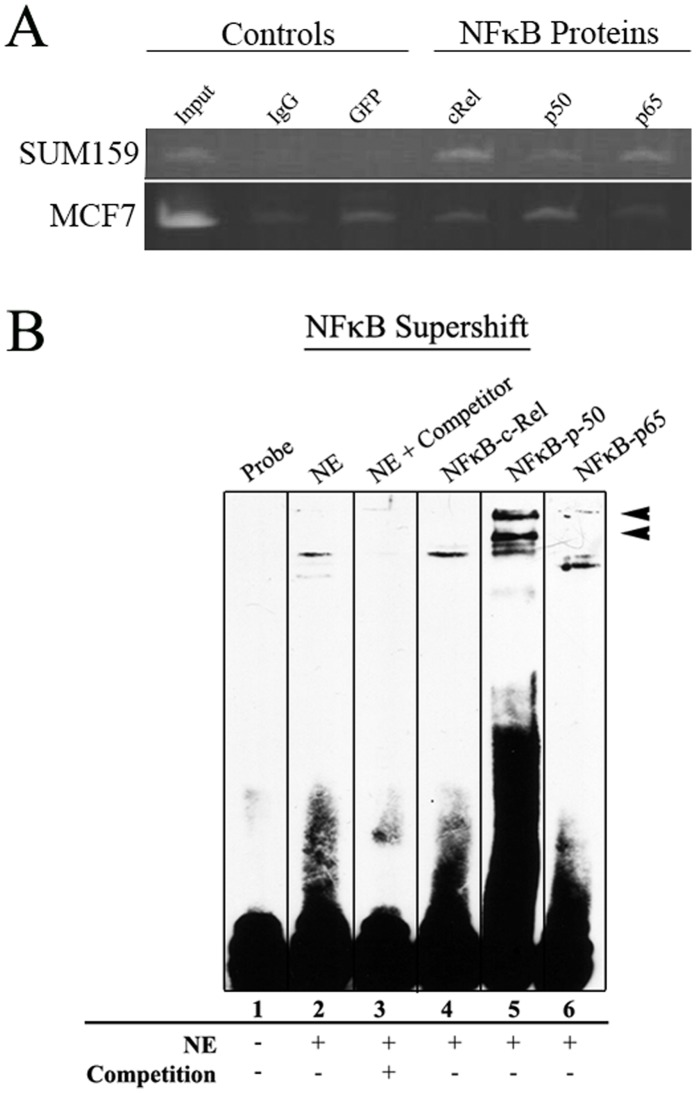
NFκB factors interact with CR1.ChIP assays were performed to identify CR1 interacting transcription factors. Rabbit IgG and anti-GFP antibody served as negative control. (A) Strong PCR amplification of CR1 region with NFκBp50 and p65 were seen in SUM159 samples. MCF7 samples showed bands with intensities equal to the negative control. (B) Supershift with NFκB antibodies was performed with SUM159 nuclear extract. Anti NFκB-p50 and p65 antibodies were able to supershift the band, but NFκB-cRel antibody resulted in no shift.